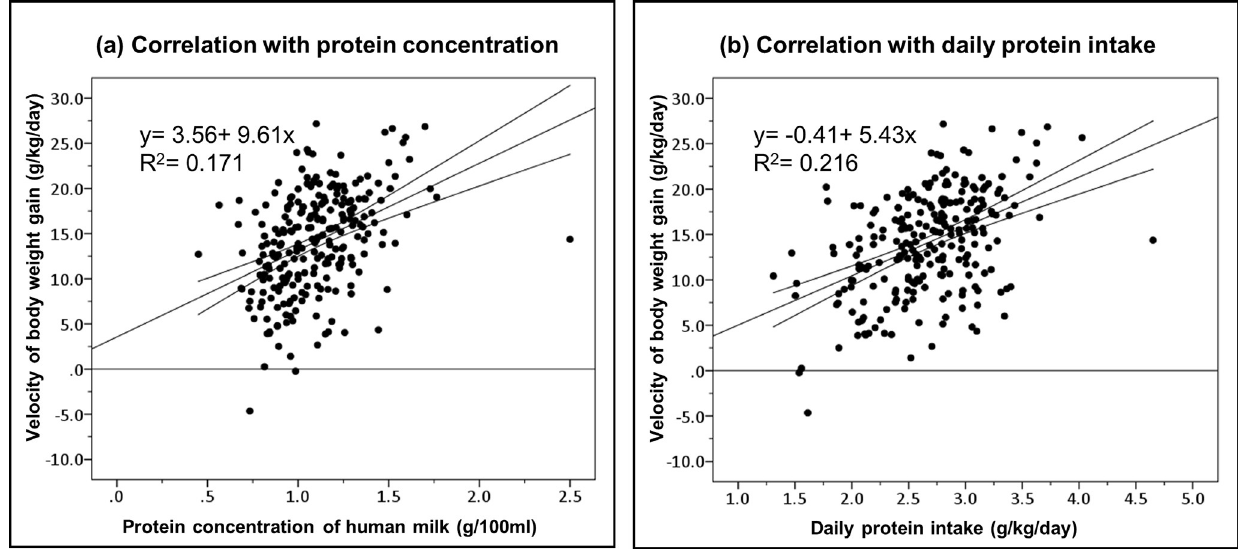
Fig 3. Linear relationship between protein content and body weight gain. The correlation of the velocity of body weight gain with (a) protein concentration in human milk and (b) daily protein intake. Spots in the figure were unadjusted values. The simple linear regression equation is indicated by the straight line. The upper and lower curves represent the 95% confidence interval of the